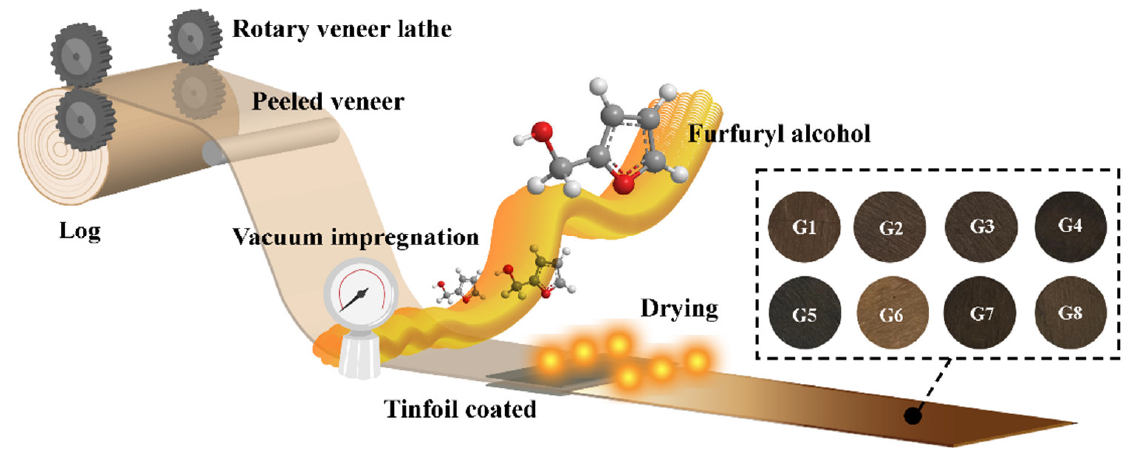
Figure 1. Preparation process of furfuryl alcohol modified poplar veneer.